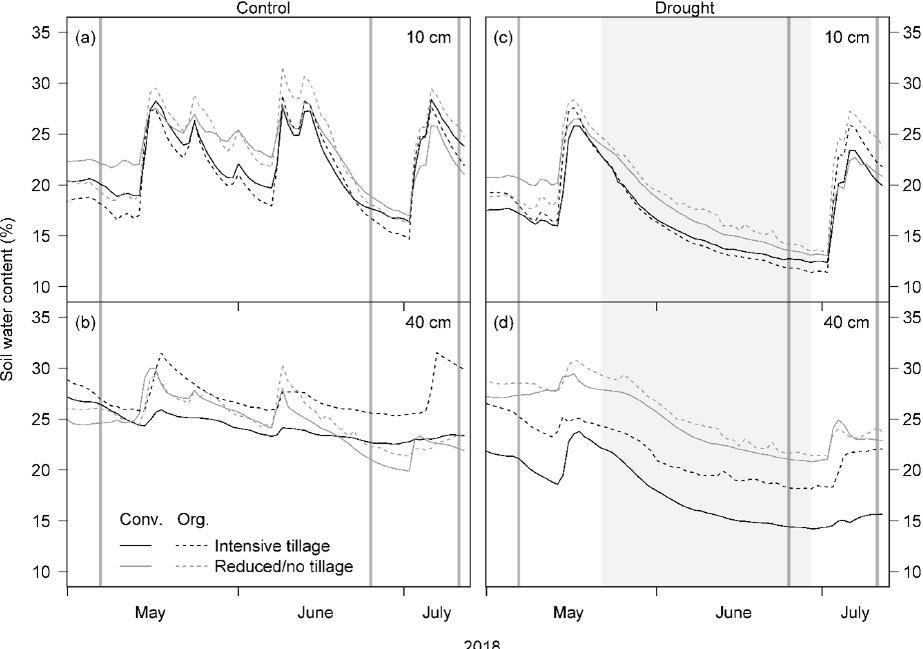
Figure 2. Daily mean soil water content at 10 and 40cm depth in (a, b) control and (c, d) drought subplots under different cropping systems ( n = 2 each; Conv. for conventional and Org. for organic). Vertical lines indicate sampling dates for stable water isotopes on 7 May, 25 June, and 11 July 2018. Shaded areas in (c) and (d) represent the drought treatment period from 22 May to 28 June